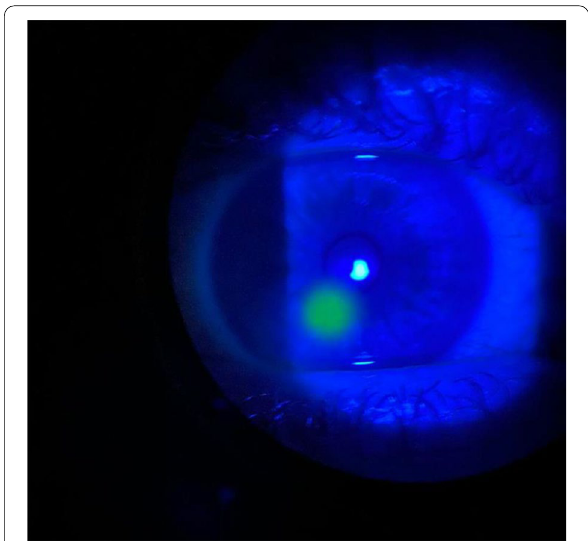
Fig. 1 Anterior segment slit lamp examination showing an area of homogenous fluorescein uptake located